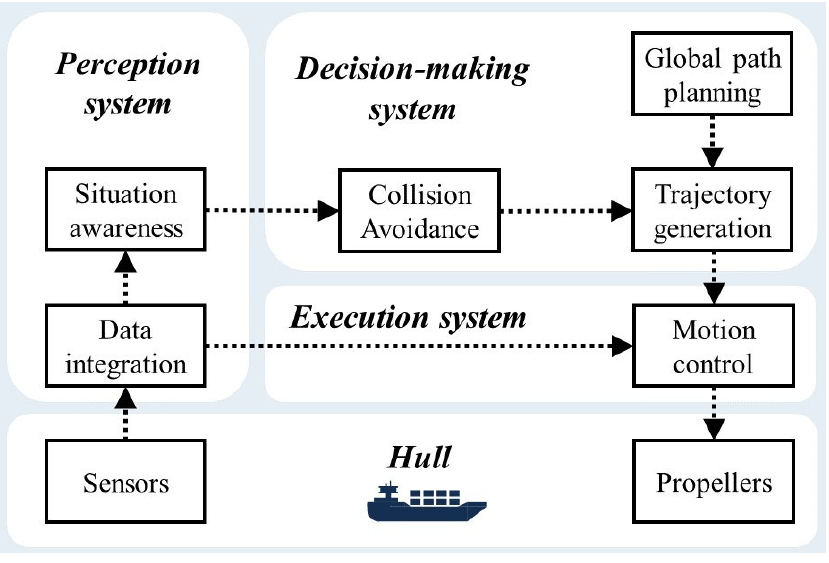
Figure 1. Illustration of subsystems within an intelligent ship system.